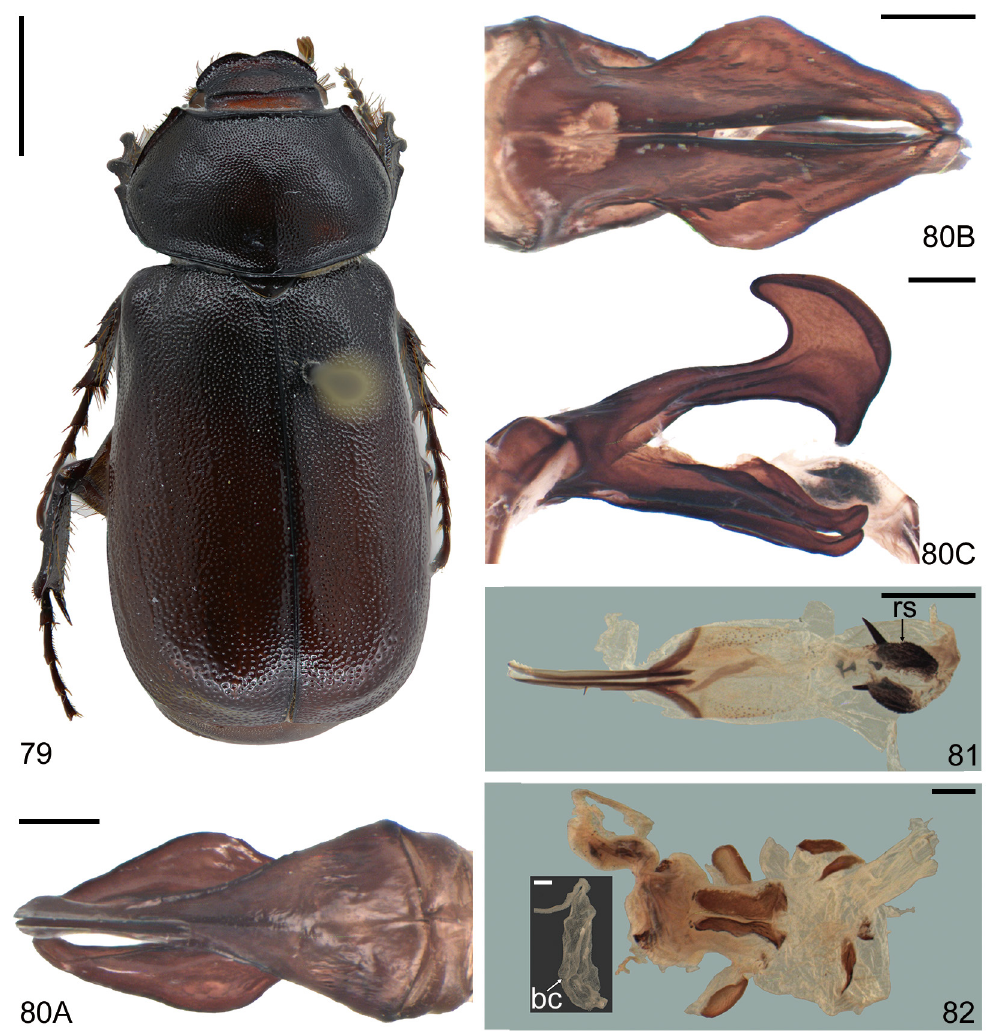
view. 80 . Parameres in dorsal (A), ventral (B) and lateral (C) views. 81 . Endophallus and temones in dorsal view. 82 . Paralectotype, ♀ (MFNB), genitalia in dorsal view. Scale bars: 79 = 5.0 mm; 80–82 = 1.0